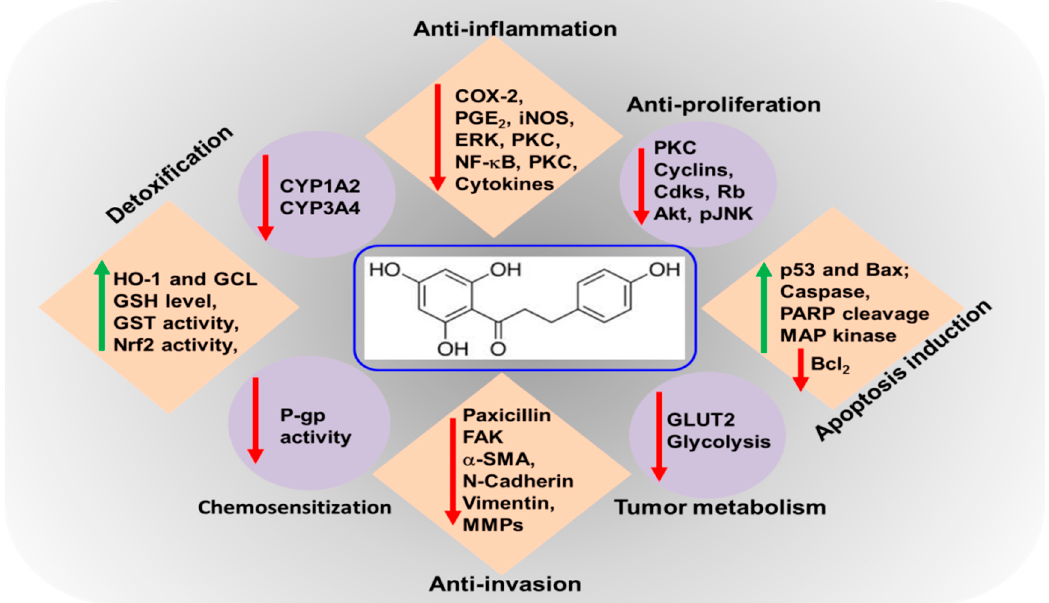
Figure 1. Molecular targets of phloretin as an chemoprevention agent. Anti-inflammation: COX-2 (Cyclooxygenase-2), PGE 2 (Prostaglandin E 2 ), i NOS (Nitric oxide synthases), ERK (extracellular-signal-regulated kinases), PKC (Protein kinase C), NF-kB (nuclear factor kappa-light-chain-enhancer of activated B cells). Anti-proliferation: CDKs (Cyclin-dependent kinases), Rb (Retinoblastoma protein), Akt (protein kinase B), p-JNK (Phospho-c-Jun N-terminal kinases), Apoptosis induction: Bax (Bcl-2-associated X protein), PARP (Poly ADP-ribose polymerase), Bcl 2 (B-cell lymphoma 2). Tumor metabolism: GLUT2 (Glucose transporter 2). Anti-invasion: FAK (focal adhesion kinase), α -SMA (Smooth muscle actin), MMPs (Matrix metalloproteinases). Chemosensitization: P-gp (P-glycoprotein 1). Detoxification: HO-1 (heme oxygenase 1), GCL (Glutamate Cysteine Ligase), GSH (glutathione), GST (Glutathione S-transferases), Nrf2 (Nuclear factor erythroid-related factor-2).